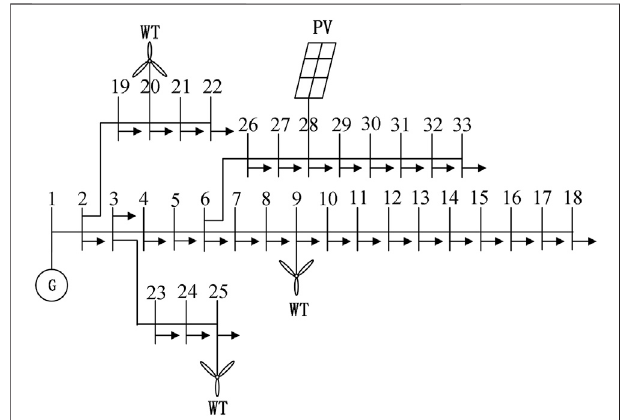
FIGURE 4 | Extended IEEE-33 bus test